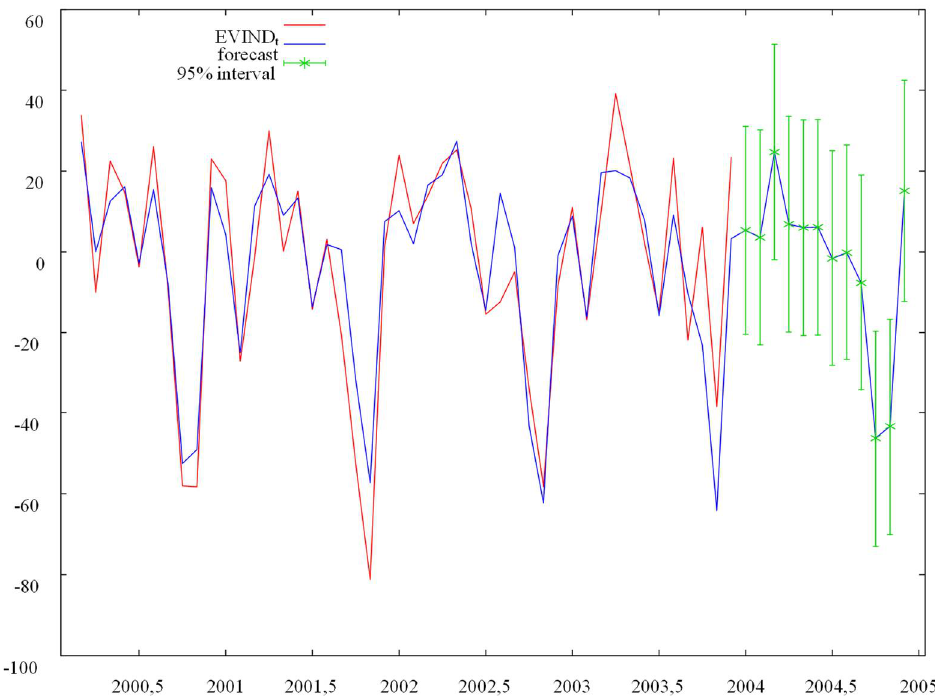
Figure 2. Convergent monthly forecast of the company’s debt recovery efficiency (EVIND Tp ) for the year 2004. Source: own calculations using the GRETL package.